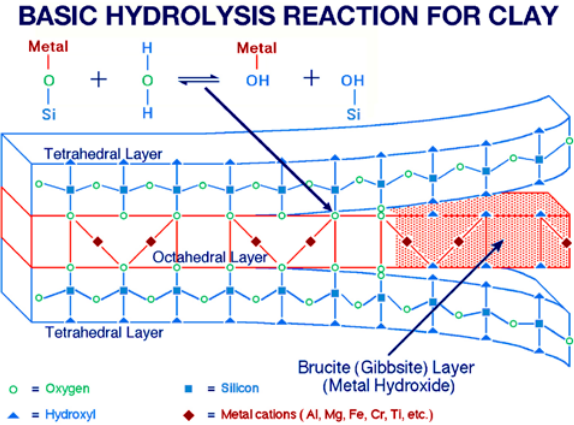
Figure 48. The external surfaces of natural clay platelets are fully hydrated. In the marine environment, further hydrolysis can there- fore only progress inwardly from the edges of the platelets (within the octahedral